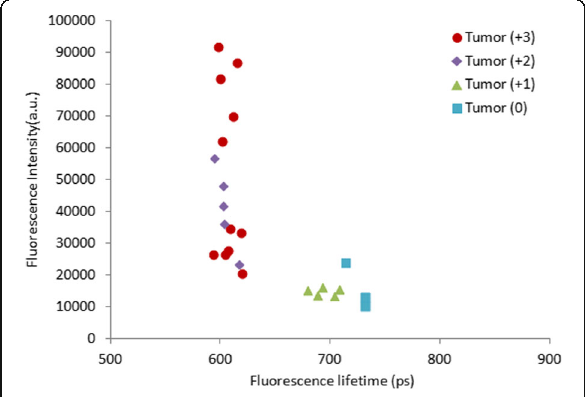
Fig. 3 In vivo fluorescence lifetime at the tumor site vs. HER2 expression in the tumor measured by ELISA after tumor extraction